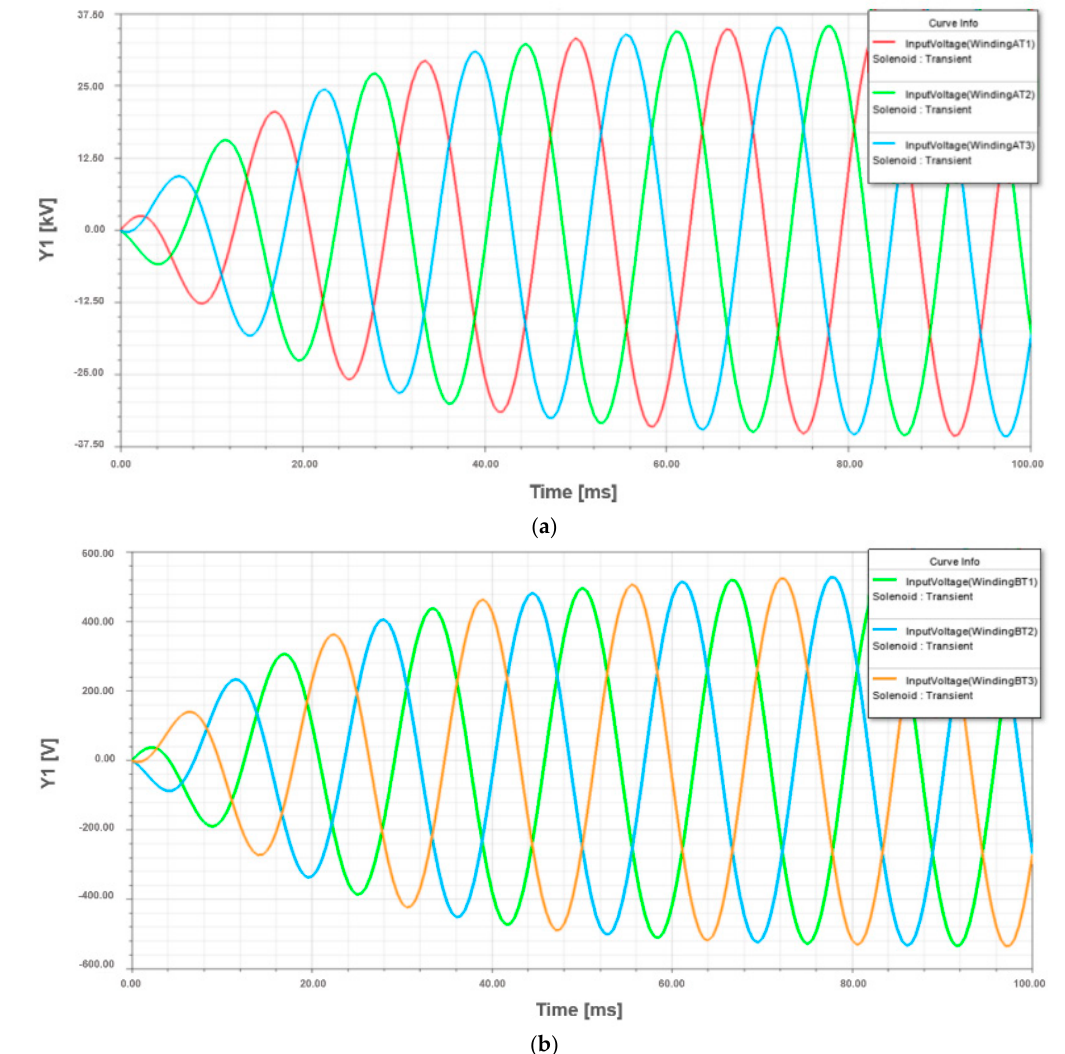
Figure 8. Winding voltage waveforms of harmonic profile design transformer: ( a ) HV winding; ( b ) LV winding.